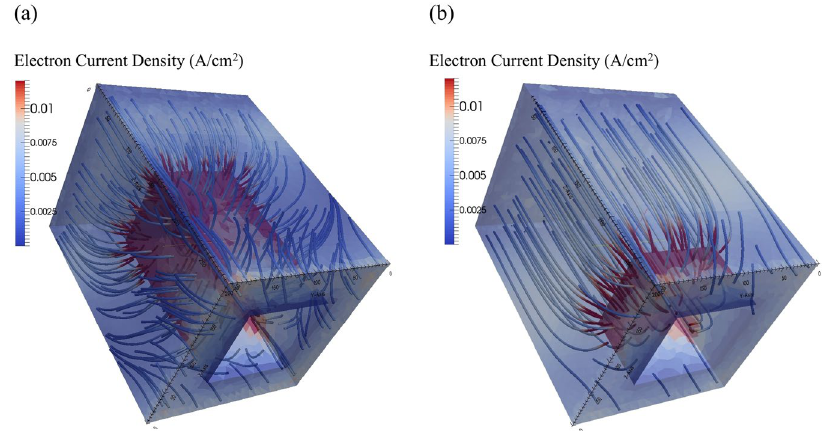
Figure 5. Electron current density magnitude (tubes) within the active layer for two different pillar heights ( a ) h = 200 nm, ( b ) h = 80 nm. By introducing pillars in the organic solar cell, the surface area between the active layer and the back contact increases. This effectively leads to a more efficient free carrier collection and hence to an increased FF as compared to the planar reference cell.